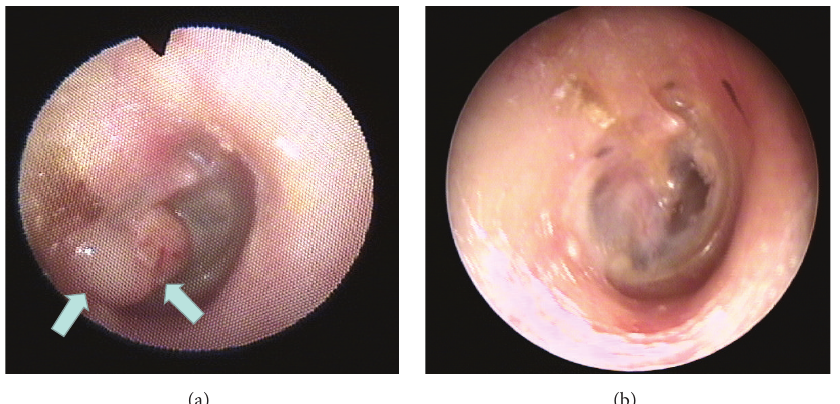
Figure 1: Preoperatory (a) and postmyringoplasty (b) otomicroscopic images.